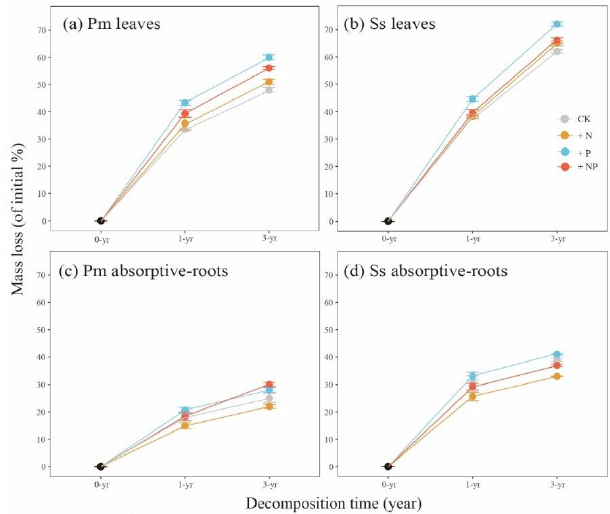
Figure 2. Mass loss of four substrates under different treatments in the 1-year and 3-year stages of decomposition. Significant differences between the means were determined using Tukey’s honestly significant difference test ( p < 0.05). CK, control; +N, nitrogen addition; +P, phosphorus addition; +NP, combined additions of nitrogen and phosphorus; Pm , Pinus massoniana ; Ss , Schima superba.